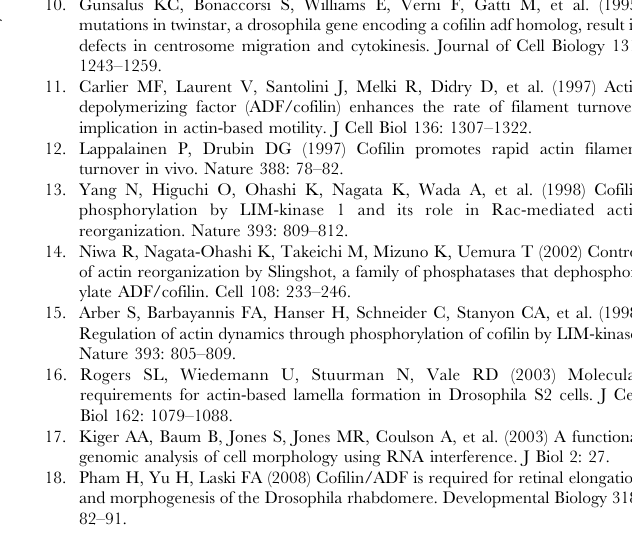
relative to untreated control cells. Figure S2 Serum starvation or oligomycin does not lead to increased levels of phospho-Twinstar. S2 cells were left untreated, serum starved for 5 hours or treated with 100 nM oligomycin for 15 or 60 minutes. Immunoblots of whole cell extracts were probed for p-Tsr levels and the starvation effect (ATP depletion) was confirmed with an antibody against phosphorylated AMP-activated kinase. Tubulin was used as loading control. CTRL= control/untreated cells. Figure S3 SHSY-5Y cells differentiate and show mor- phological changes upon treatment with retinoic acid. ( A–C ) Control SHSY-5Y cells were differentiated with RA, plated on poly-lysine and analyzed after 24 hours for their morphology (using rhodamin-phalloidin marking F-actin, red) and differenti- ation status (using b -III-Tubulin staining, green). In non treated SHSY-5Y cells no b -III-Tubulin positive cells were observed (data not shown). In RA-treated cultures undifferentiated and differen- tiated cells were visible. Undifferentiated cells showed very short filopodia, no filamentous actin was observed and b -III-Tubulin was not expressed ( A and marked with white arrow heads in B ). After 24 hours RA treatment most differentiated cells showed lower b -III-Tubulin expression associated with strong filamentous actin fibers (purple arrow heads) and an angular cell shape ( B,C ). 48 hours after seeding many differentiated cells showed an elongated shape, neurite growth and high expression of b -III- Tubulin ( Figure 5C–D, main text ). The presence of b -III- Tubulin positive neurites was used to quantify the effect of HOPAN on differentiation by RA and to quantify the rescue potential of pantethine (Figure 5D–G, main text).